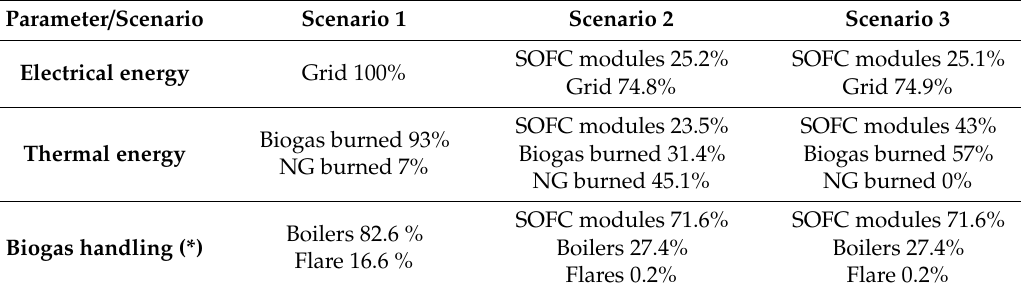
Table 1. Biogas management and energy sources in the three